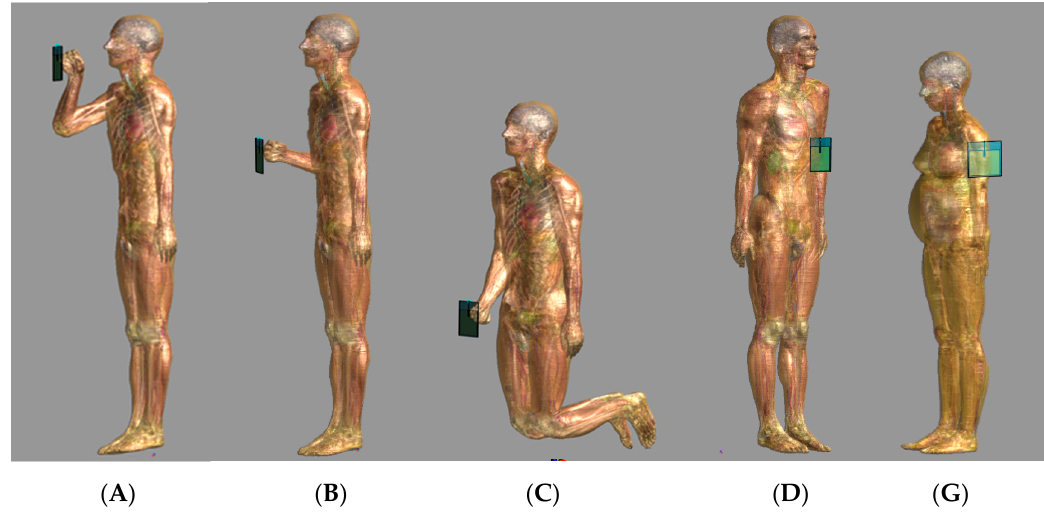
Figure 3. Exposure scenarios: (1) exposure of the operator holding an RFID gun in the hand ( A —in front of the face, 20 cm away from it; B —in front of the chest, 20 cm away from it; C —holding the arm lowered, 16 cm away from the abdomen), and (2) exposure of people approaching the RFID gun held by the operator in scenario B ( D —in front of the chest (male model), 5 cm away; corresponding scenario involving the pregnant female model is F (not shown in the figure); G —at the side of the body, at the height of the chest (pregnant female model), at a distance of 5 cm to the arm; corresponding scenario involving the male model is E (not shown in the figure)).